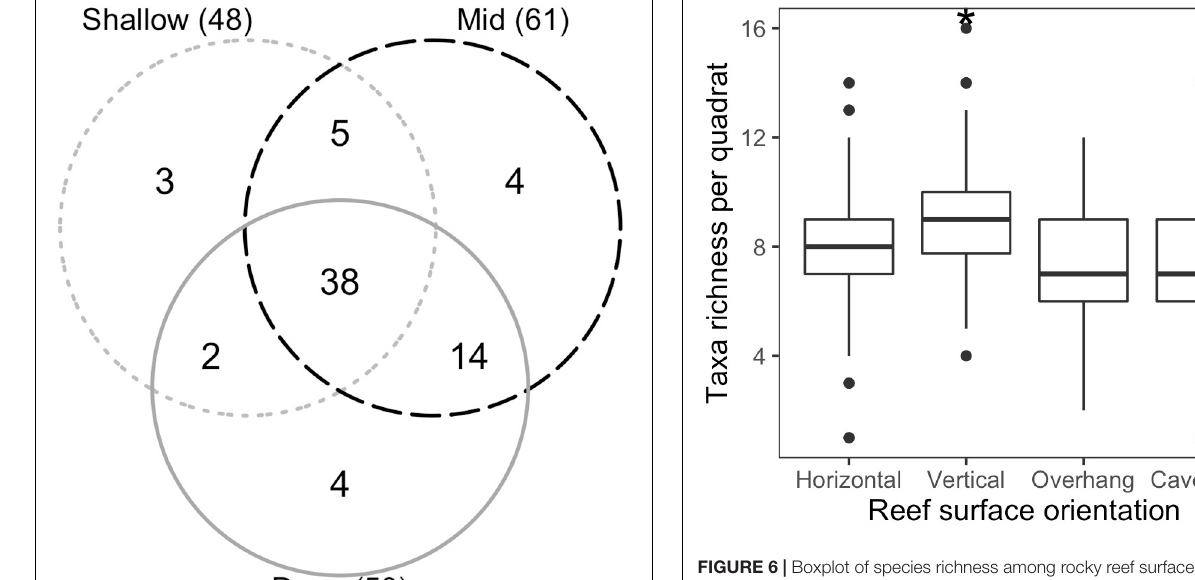
FIGURE 6 | Boxplot of species richness among rocky reef surfaces orientations (Horizontal, vertical, overhang, and cavefloor). The * indicates p < 0.001 obtained by randomization